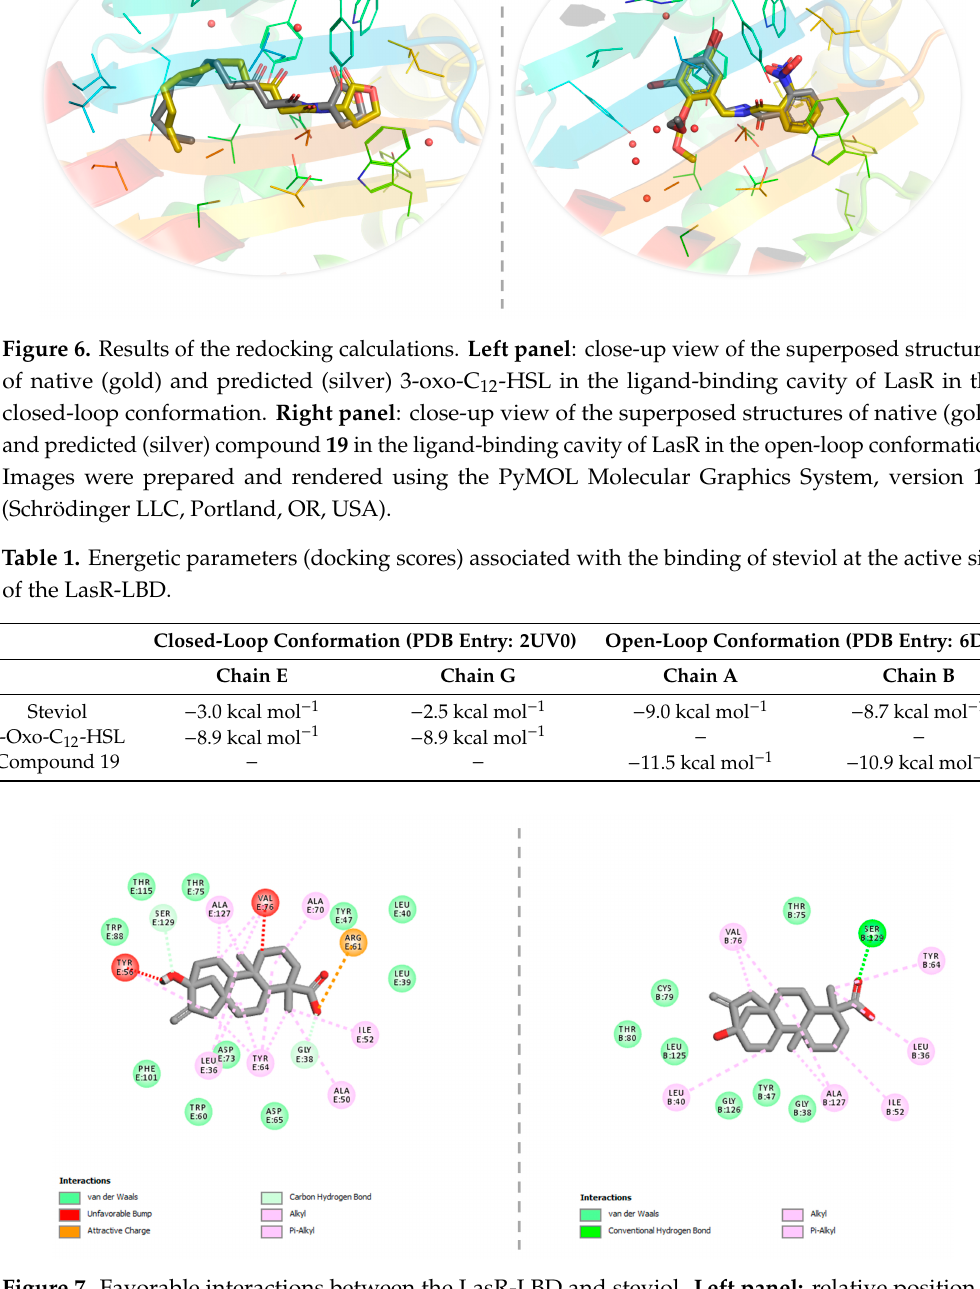
Figure 7. Favorable interactions between the LasR-LBD and steviol. Left panel: relative position of steviol with respect to the ligand-binding cavity of LasR in the closed-loop conformation. Right panel: relative position of steviol with respect to the ligand-binding cavity of LasR in the open-loop conformation. Images were prepared and rendered using Discovery Studio Visualizer, version 16.1.0 (Dassault Systèmes BIOVIA Corp., San Diego, CA, USA). Table 1. Energetic parameters (docking scores) associated with the binding of steviol at the active site of the LasR-LBD.